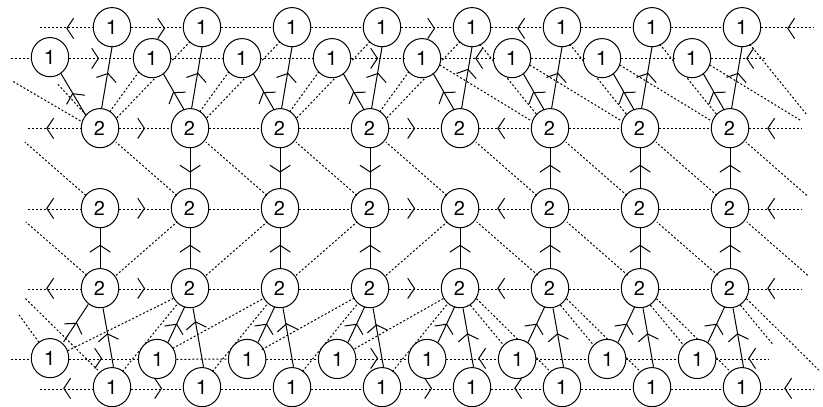
Figure 12 . Flux domain wall con(cid:12)guration with (cid:13)ux F tot = (1 ; (cid:0) 1 ; 1 ; 1 ; 0 ; 0) (cid:12) + (1 ; 1 ; 1 ; 1 ; 0 ; 0) (cid:13) in the a(cid:14)ne D 6 quiver theory on a circle. The horizontal direction is the circle direction and both ends are identi(cid:12)ed. The 4d chiral (cid:12)elds are denoted by dashed lines. There is a (cid:13)ip (cid:12)eld on each horizontal